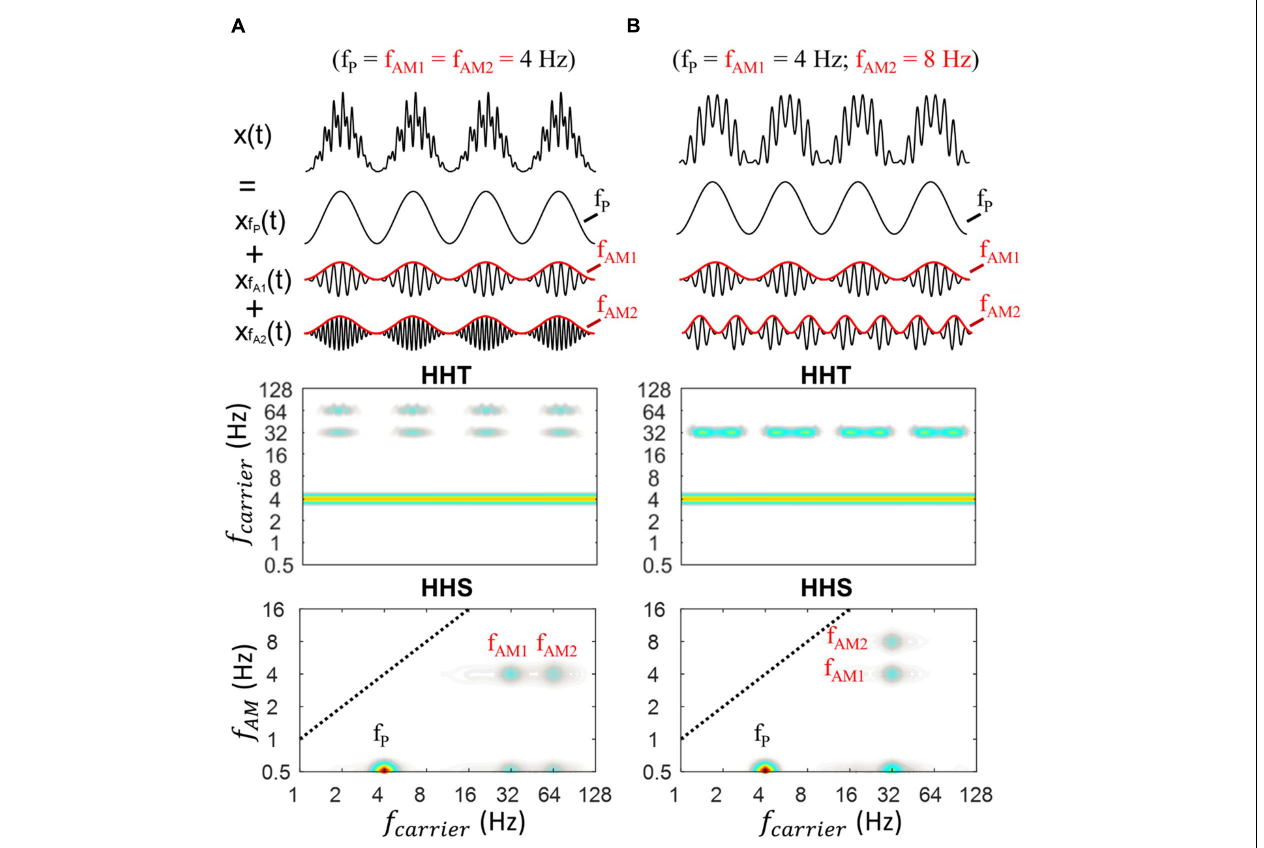
FIGURE 6 | Illustration of HHSA on a synthesized data with the sum of three oscillators (i.e., x(t) = x fP ( t ) + x fA 1 ( t ) + x fA 2 ( t ) ). (A) The synthesized PAC data, in which theta phase was coupled with low and high gamma along with their corresponding HHT and HHS (lower panels). The HHT shows time-frequency characteristics of the simulated data, in which the amplitude increases at fP, fA1, and fA2 could be seen over time, corresponding to the original properties of the signals (amplitude modulation). The HHS shows the distinct peaks at f P , f A 1 , f A 2 , f AM 1 , f AM 2 . (B) The synthesized PAC data, in which low gamma was modulated by 4 Hz (f AM 1 ) and 8 Hz (f AM 2 ) along with their corresponding HHT and HHS (lower